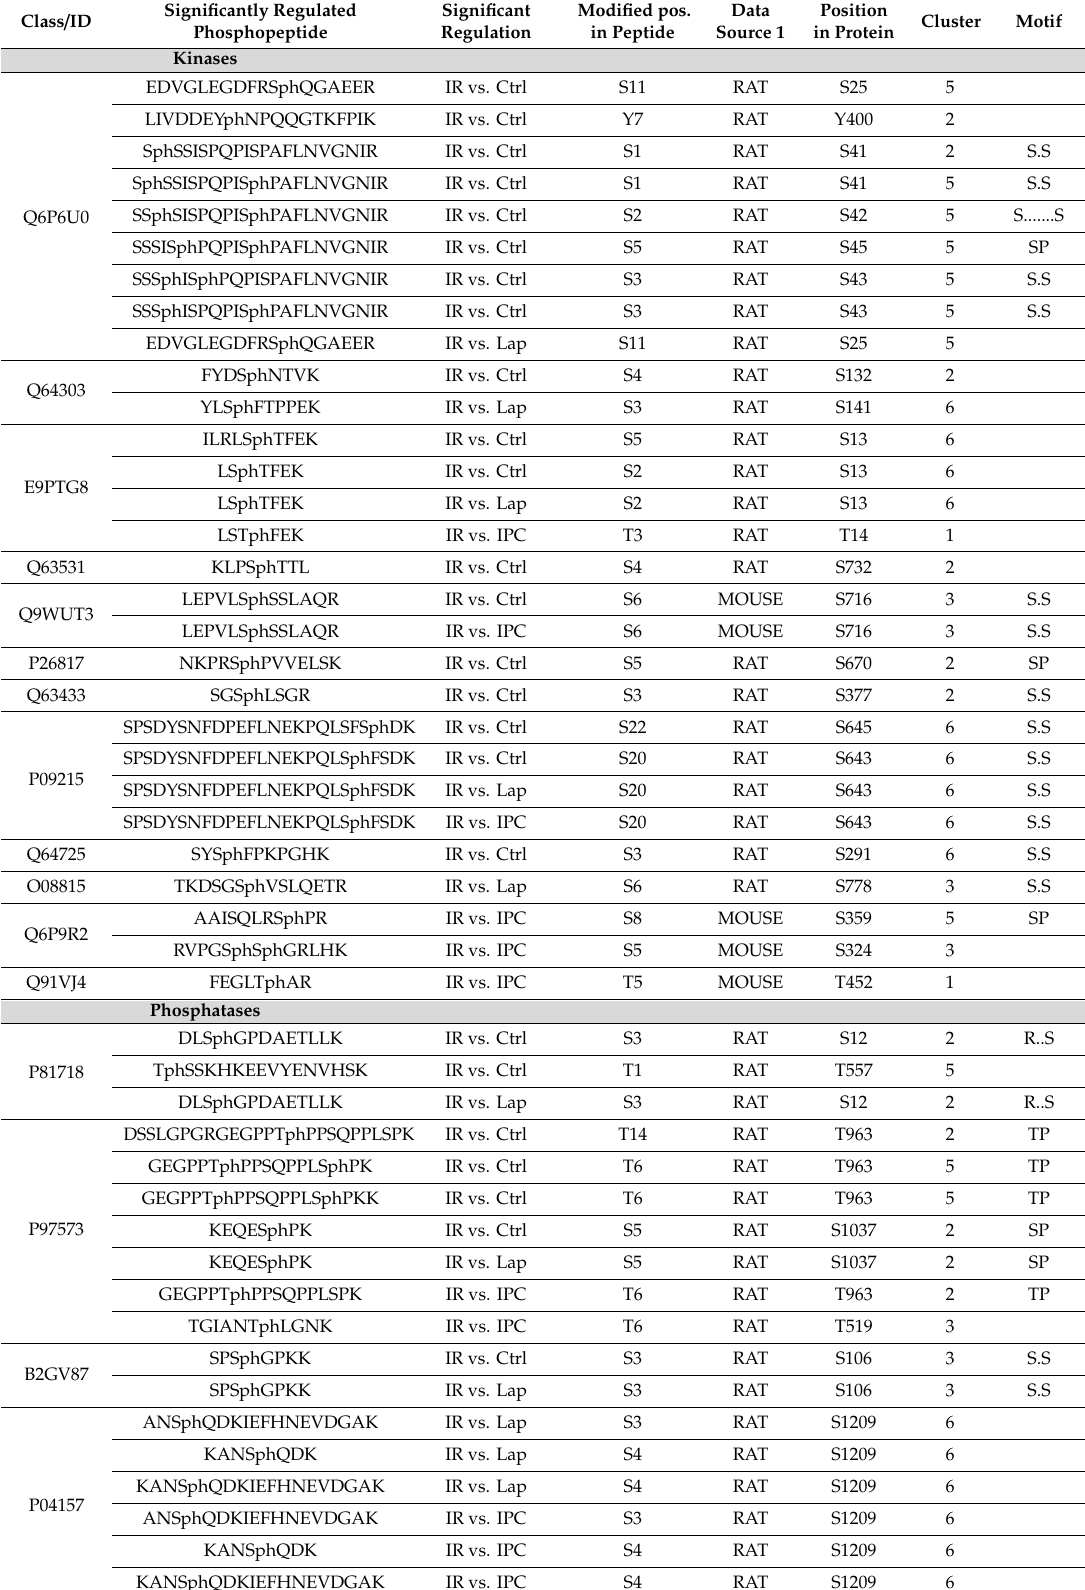
Table 2. Enriched motifs found in the regulated